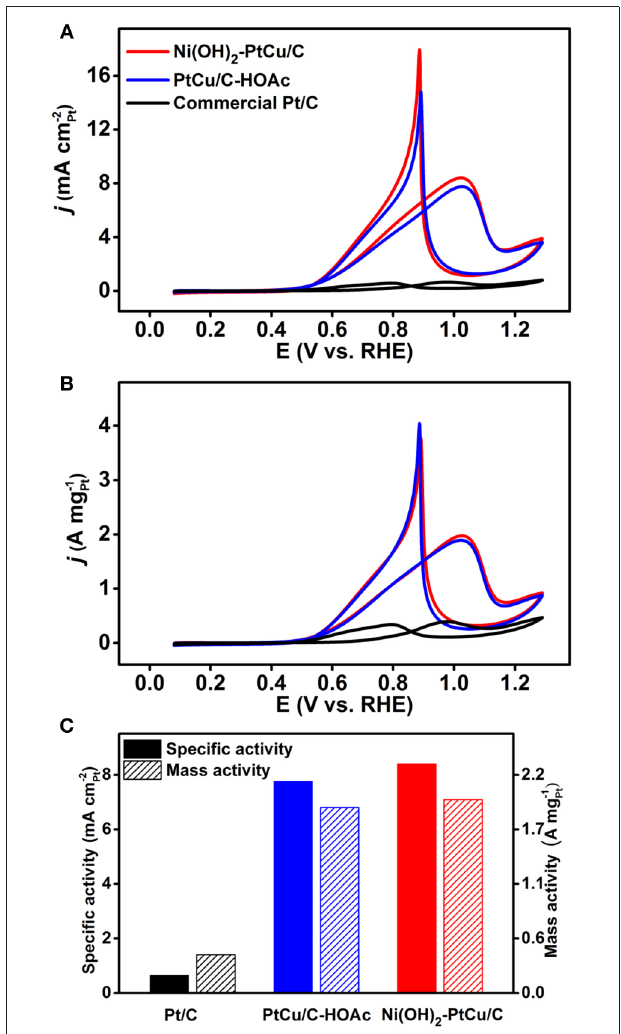
FIGURE 5 | CVs of the Ni(OH) 2 -PtCu/C, the PtCu/C-HOAc, and the commercial Pt/C normalized by (A) ECSA and (B) Pt loading recorded in Ar-saturated solutions containing 0.1M HClO 4 and 1.0M ethanol with a scan rate of 50mV s − 1 at room temperature. (C) Comparisons of the specific and mass activities toward the ethanol oxidation reaction of the three different catalysts measured at the potentials showing the maximum current density in forward